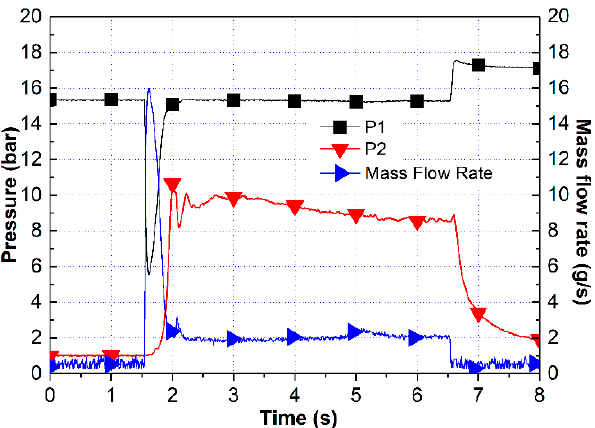
Figure 9. Test result for the Pt/BHA catalyst with the preheated catalyst bed at 350